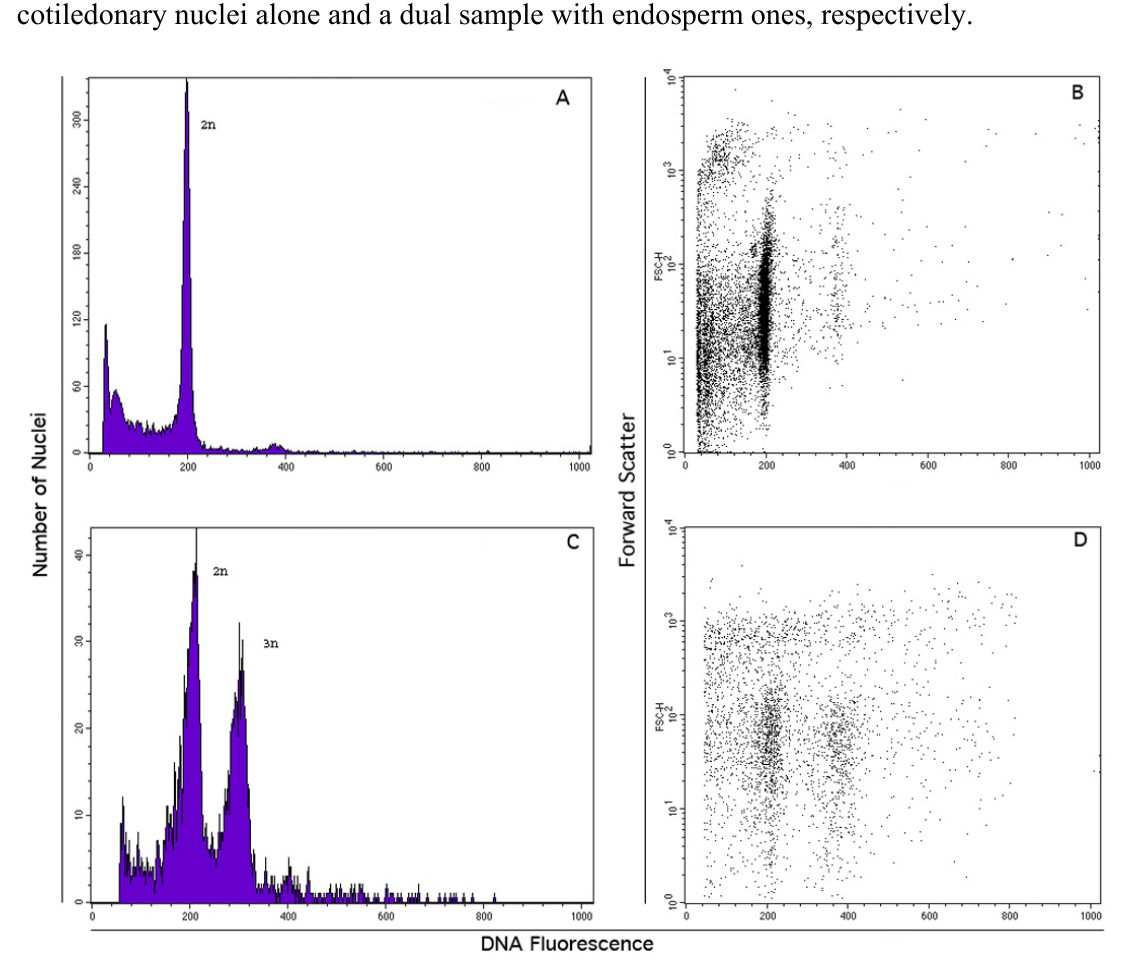
Figure 6. Flow cytometry analysis of DAPI stained J. curcas nuclei in suspension. ( A ) and ( C ): total DNA fluorescence emission from cotiledonary leaf nuclei alone and together with endosperm released nuclei, respectively; ( B ) and ( D ): dual parameter analysis of DNA fluorescence versus nuclear scatter light emission for particle discrimination showing cotiledonary nuclei alone and a dual sample with endosperm ones,